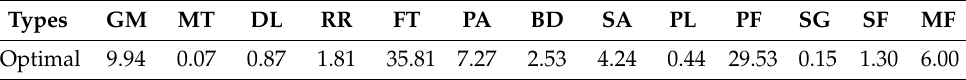
Table 3. Optimal area ratio of various landscapes in Jiangsu coastal area (unit: